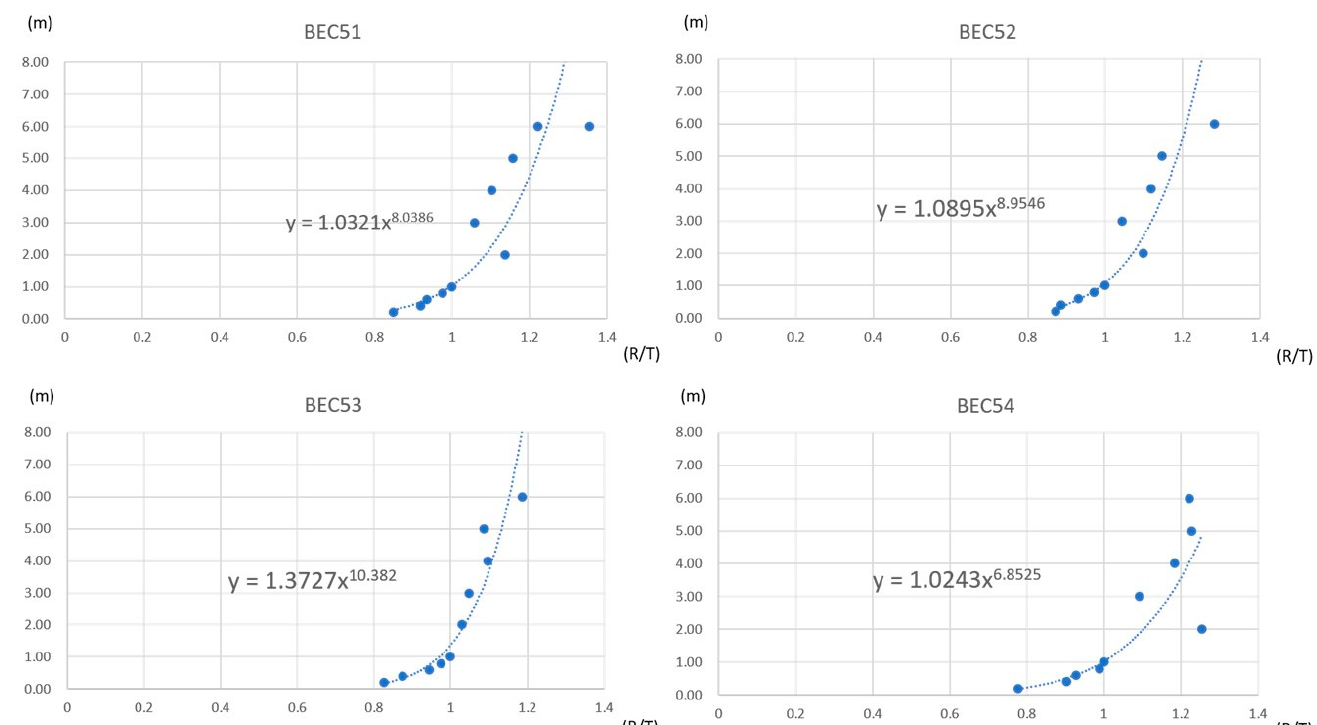
Sensors 2021 , 21 , 5181 16 of 25 Figure 12. Regression coefficients for different beacons (BEC51 – BEC54). Figure 12. Regression coefficients for different beacons (BEC51–BEC54).